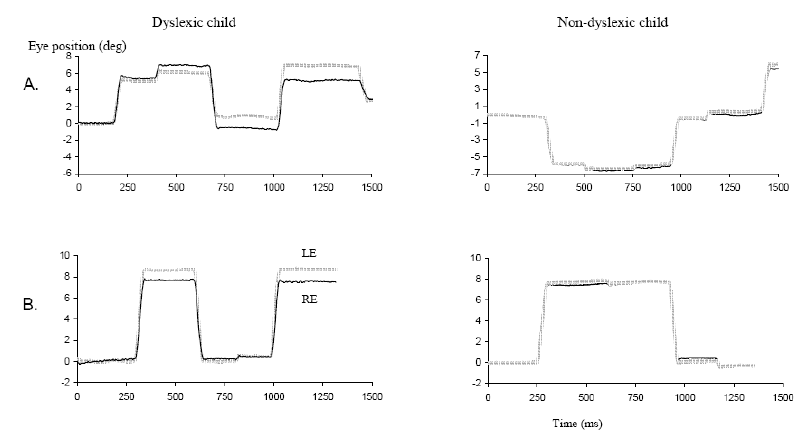
Figure 8. Typical binocular recordings of horizontal saccades during painting exploration (A) and during fixating nonius lines (B) from a dyslexic and a non-dyslexic child. For the dyslexic, the saccade is larger in the right eye, so that the eyes are not aligned at the end of the saccade but they cross or uncross relative to their position at the beginning of the saccade. During the fixation pe- riod following the saccade the eyes are drifting mildly but the drift can further increase the misalignment of the eyes due to the sac- cade. For the non-dyslexic child the disconjugate drift of the eyes reduces the crossing or uncrossing of the eyes caused by the sac-